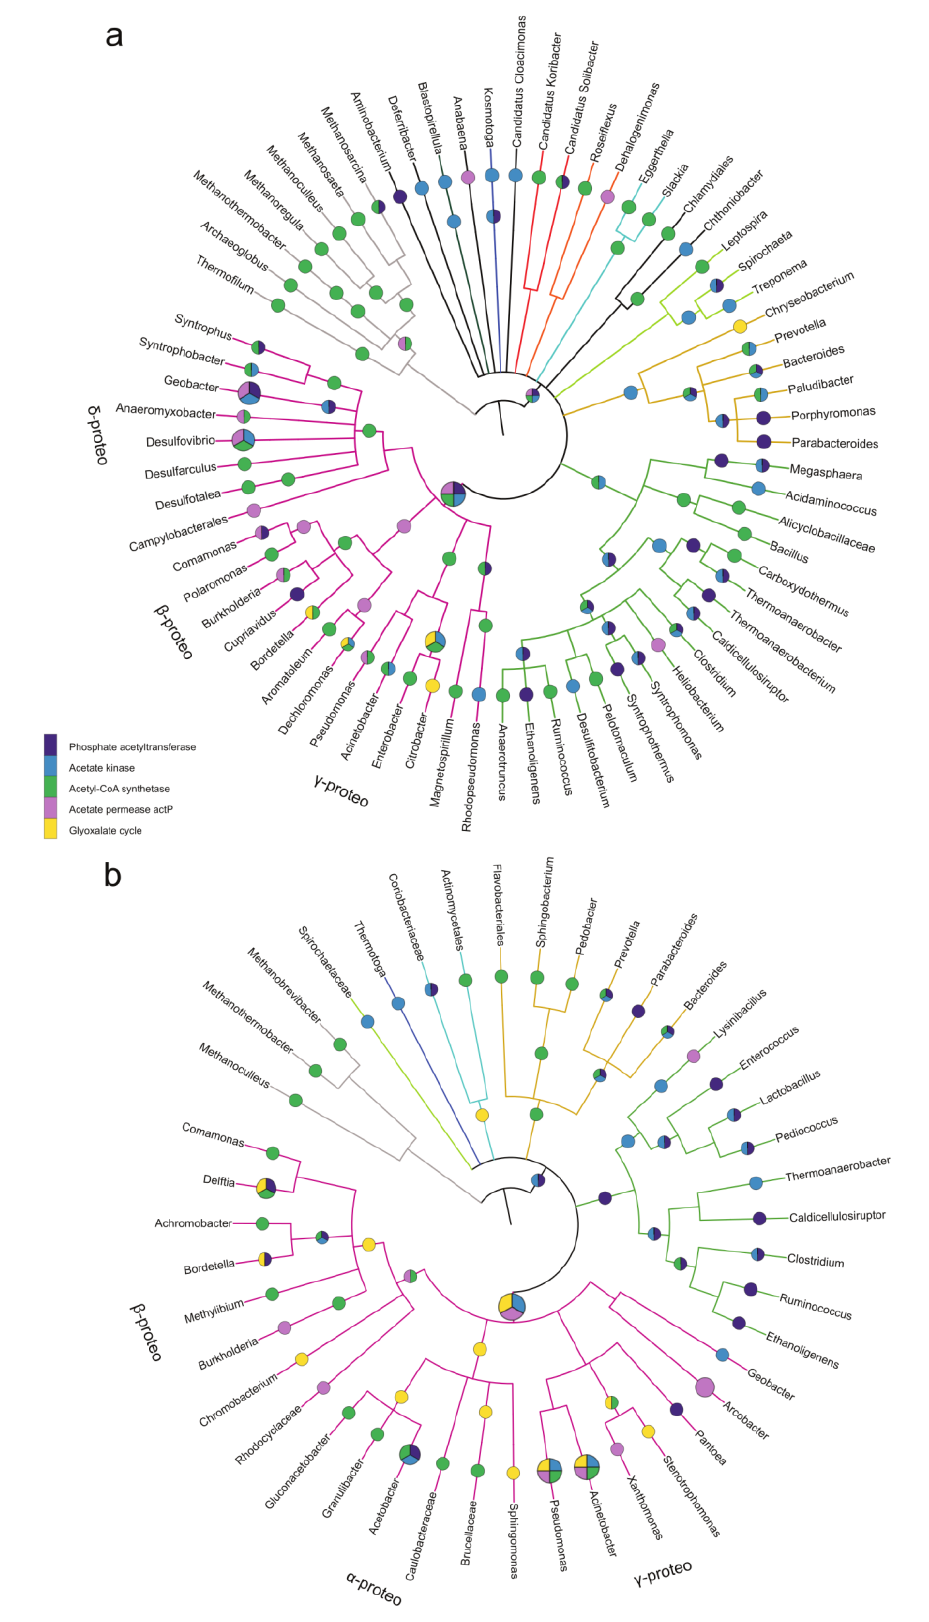
Figure 4: Acetate utilization by anodic microbial communities. Distribution of the BLAST hits (similarity 45%, E-value 10 -5 and alignment length at least 60 aa) and HMMer search for enzymes involved in acetate utilization against metagenome protein database plotted on NCBI taxonomy tree for (a) JP anode or (b) UK anode. Branches are colored according to the phylum level, circles indicate the presence of the specified enzymes in the particular phylogenetic